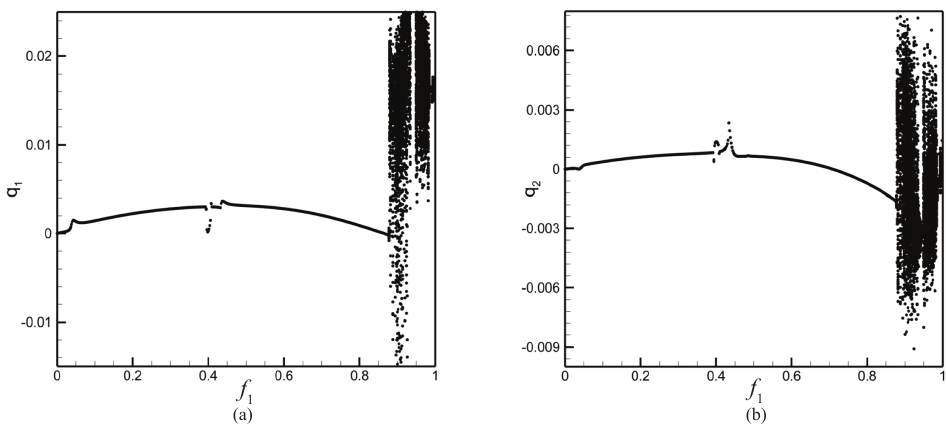
Fig. 16. Bifurcation diagrams of Poincaré points for increasing forcing amplitude on the system with γ T = 0 . 1 .